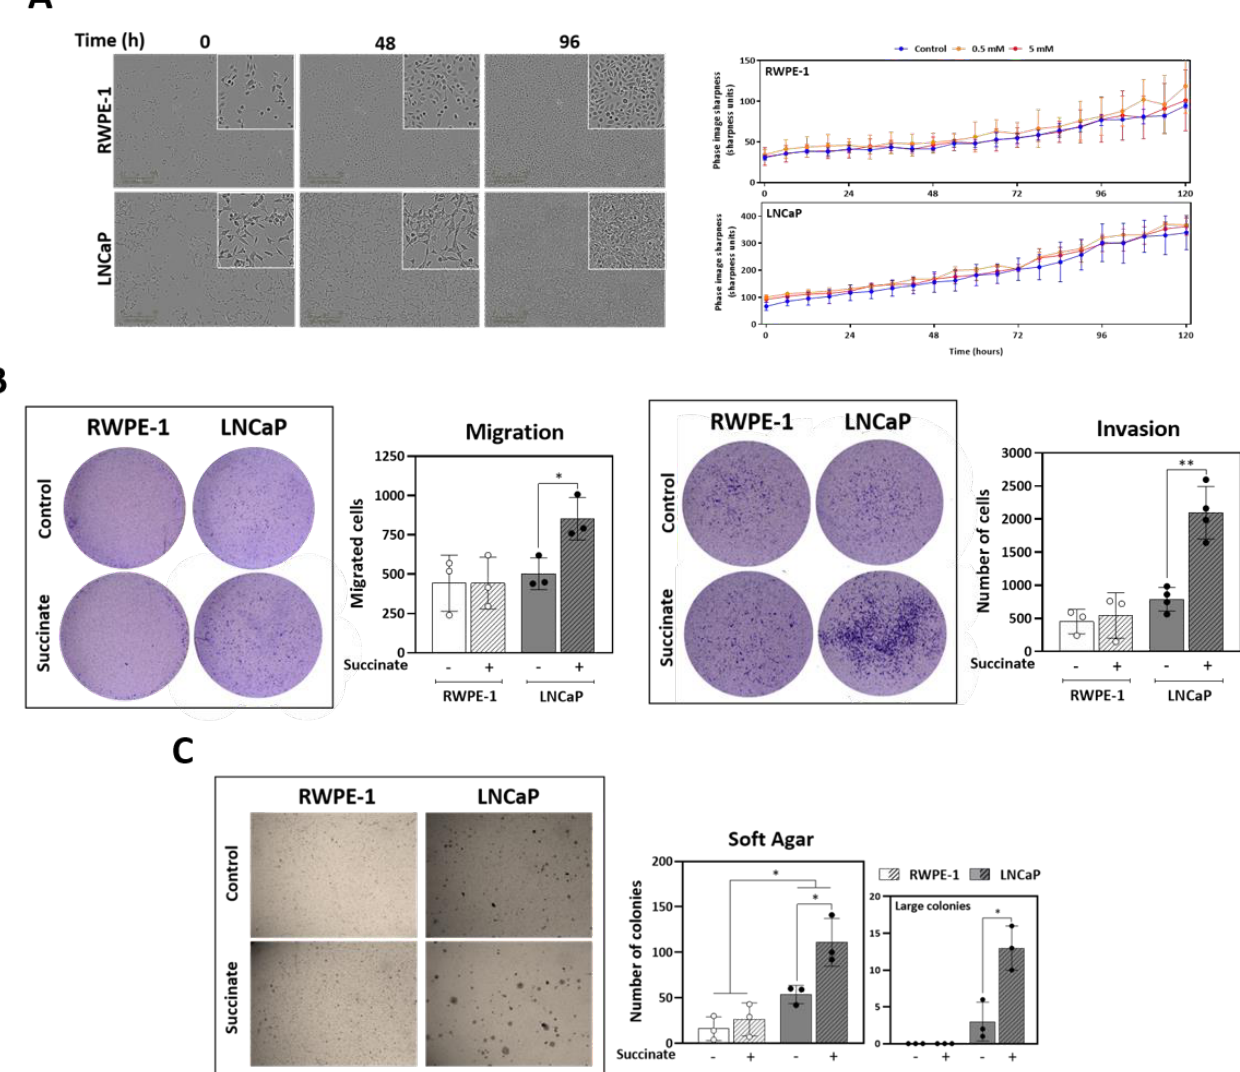
Figure 5. Proliferation, motility and colony formation. ( A ) Proliferation assay over the course of 120 h with cells incubated with 0.5 or 5 mM succinate or vehicle ( N ≥ 4, n = 2). ( B ) Transwell cell migration and invasion capacity in Matrigel™, respectively, during 48 h incubation with 5 mM succinate or vehicle ( N ≥ 4, n = 3). ( C ) Anchorage-independent growth colony formation in soft agar. Cells were incubated with 5 mM succinate or vehicle for 2 weeks ( N ≥ 4, n = 2). Median and IQR. Paired t -tests and Wilcoxon matched-pairs signed rank between control and treated cells. * p = 0.05, ** p < 0.001.